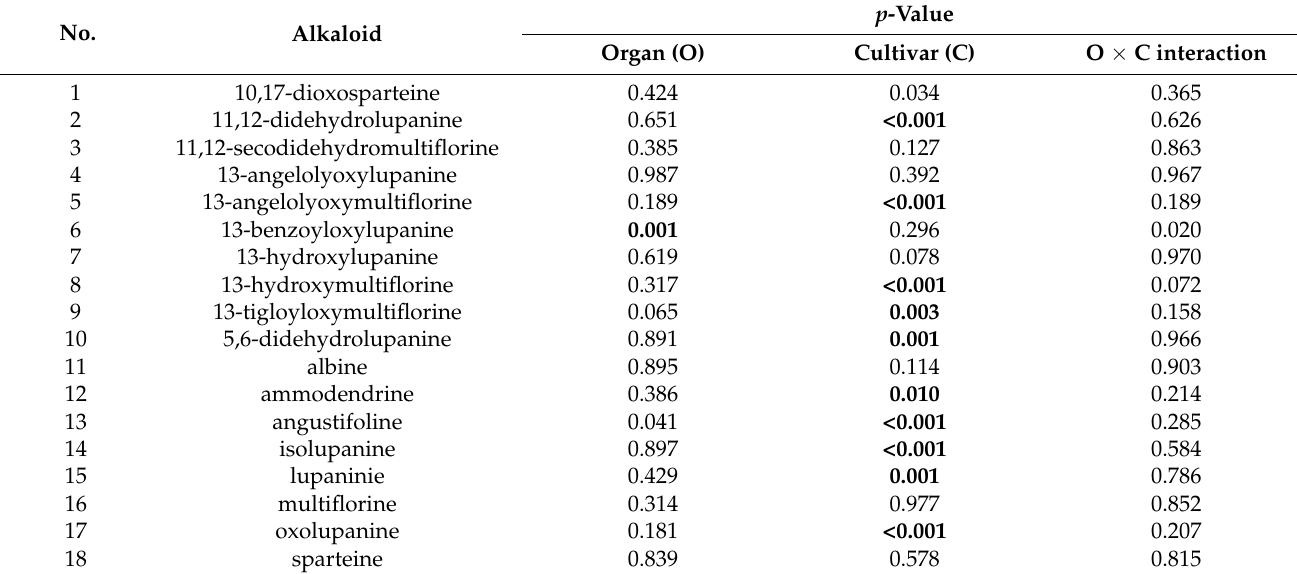
Table 5. Summary of ANOVA analysis testing the effects of plant organ, plant cultivar, and their interaction on the relative abundances of particular alkaloids in two narrow-leafed lupin cultivars—Oskar (bitter phenotype) and Regent (sweet phenotype). Effects were considered significant for p < 0.01 (marked in bold).